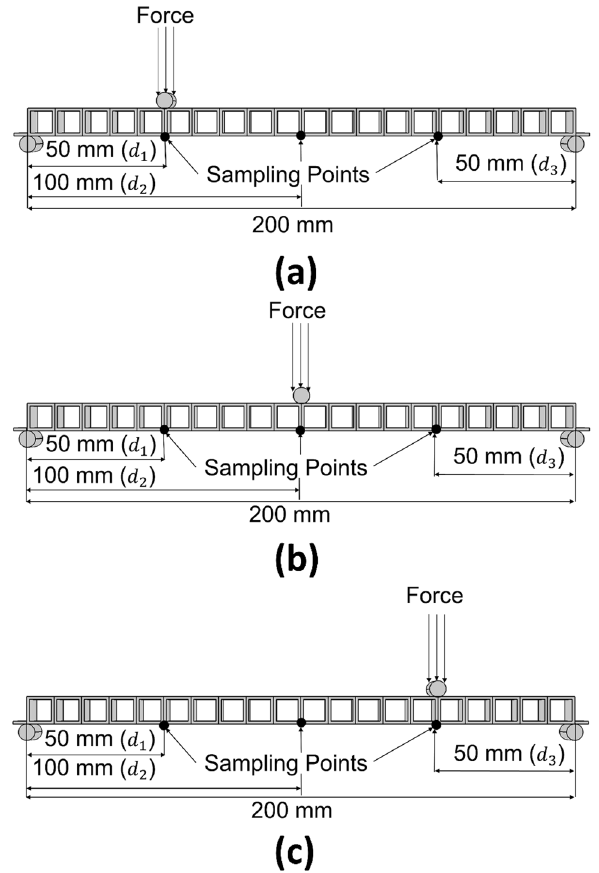
Figure 6. The 20 voxel beam shows the three load and deflection sampling points at the 1/4th, 1/2, and 3/4th distances along the length of the beam